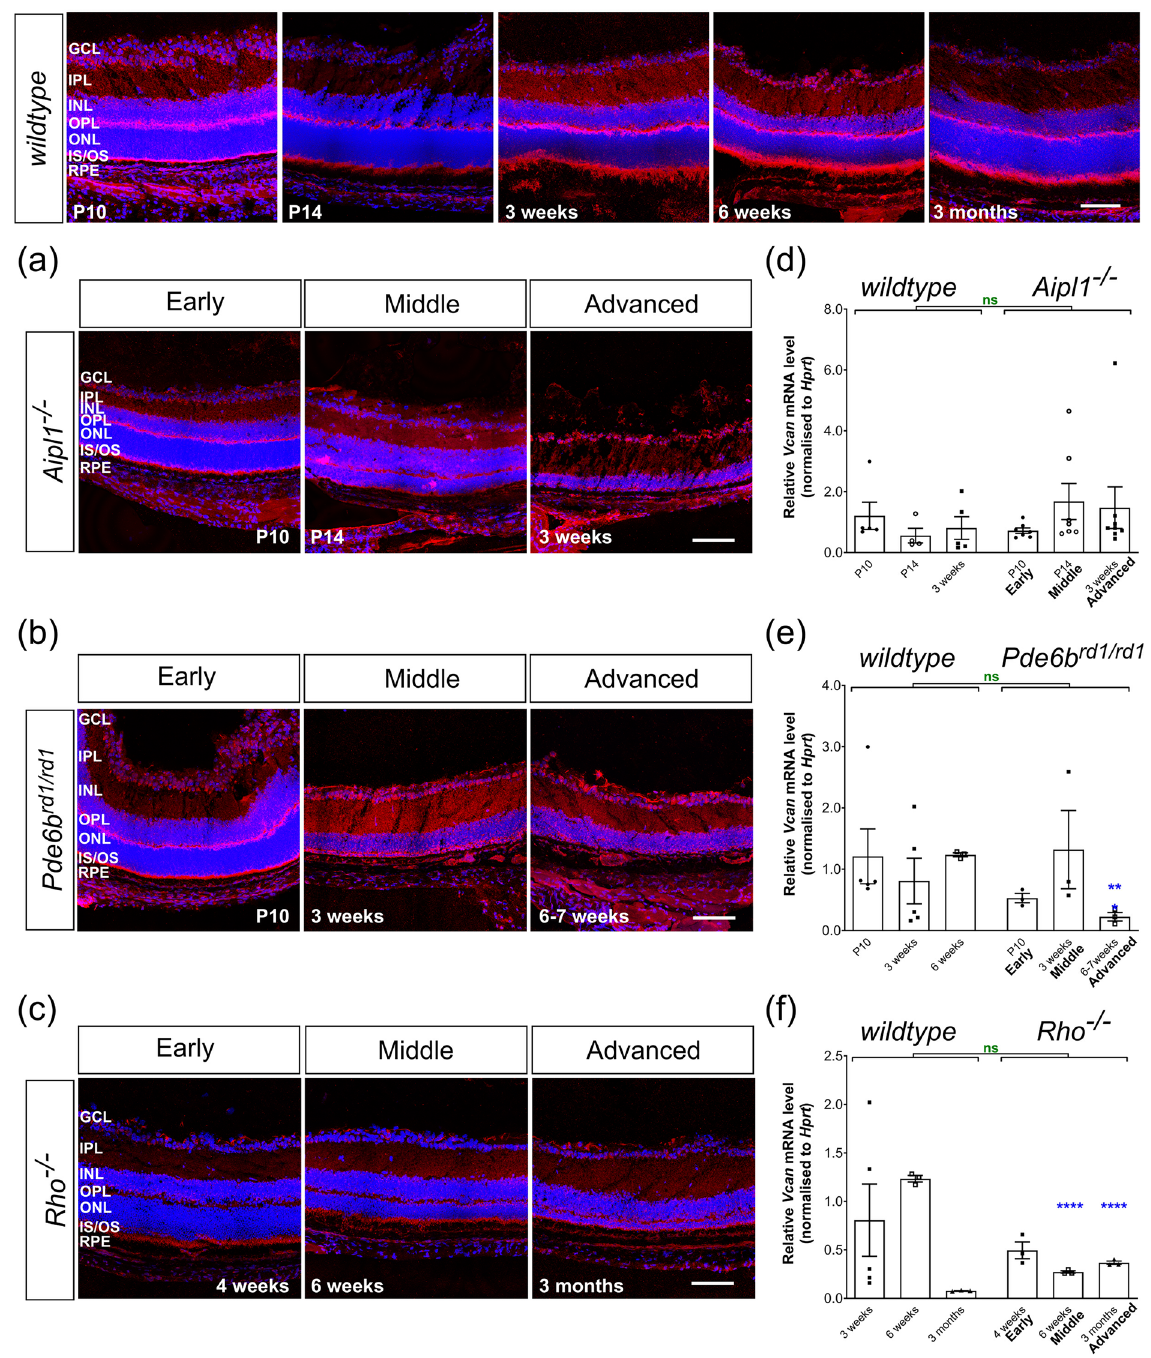
Figure 3. Versican expression remains similar to wildtype during degeneration. ( a )–( c ), Immunolabelling for Versican ( red ) was detected in all the layers of the retina in wildtype , Aipl1 -/- and Pde6b rd1/rd1 with relatively strong signals in the INL and IPL, particularly in mid and advanced stage Pde6b rd1/rd1 and advanced-stage Rho -/- retinae. ( d )–( f ) Vcan mRNA levels were largely unchanged in Aipl1 -/- and Pde6b rd1/rd1 retinae (with the exception of a reduction at 6 weeks age of Pde6b rd1/rd1 mice). ( f ) In Rho -/- , Vcan mRNA expression remained similar between P10 and 3 months of age, decreasing slightly, but remained significantly higher than age-matched wildtype mice. N.B. mRNA levels shown for wildtype are the same as in Fig. 1c. Scale bar, 100 µm. * p < 0.05, ** p < 0.01, *** p < 0.001, **** p < 0.0001 (one-way ANOVA test with Bonferroni’s correction, black ; unpaired t-test for age-matched comparisons between wildtype and disease model, blue ; two-way ANOVA test applied for assessments of change over time, red ). ONL—outer nuclear layer; OPL—outer plexiform layer; INL—inner nuclear layer; IPL—inner plexiform layer; GCL—ganglion cell layer. Nuclei are counter stained with Dapi ( blue